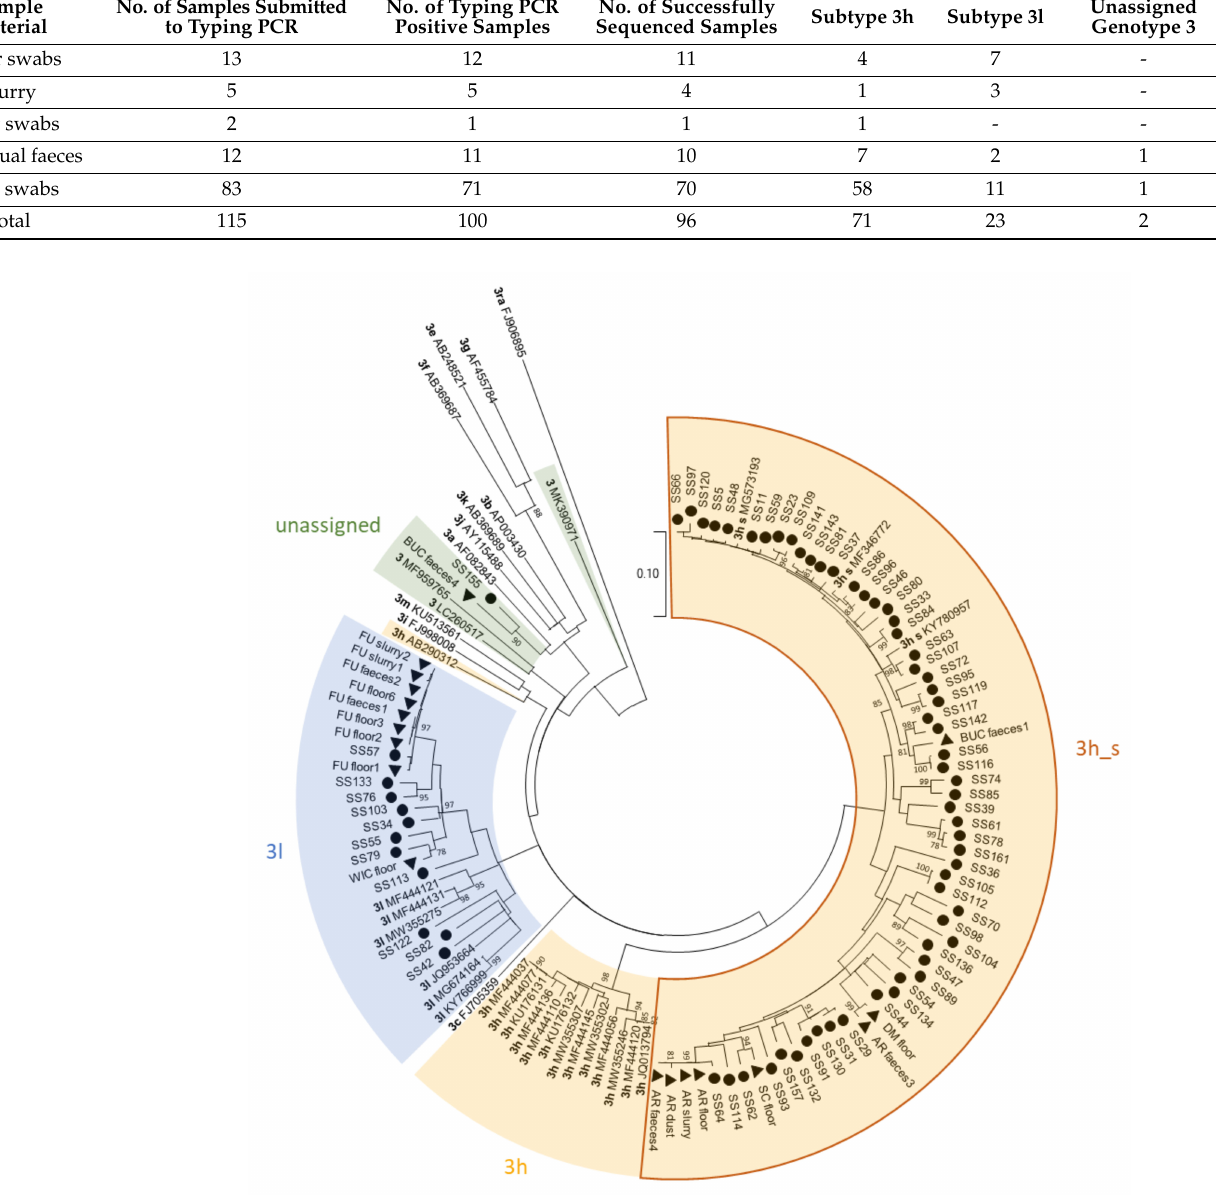
Figure 3. Phylogenetic tree based on partial HEV ORF2 sequences with a length of 493 nt. The